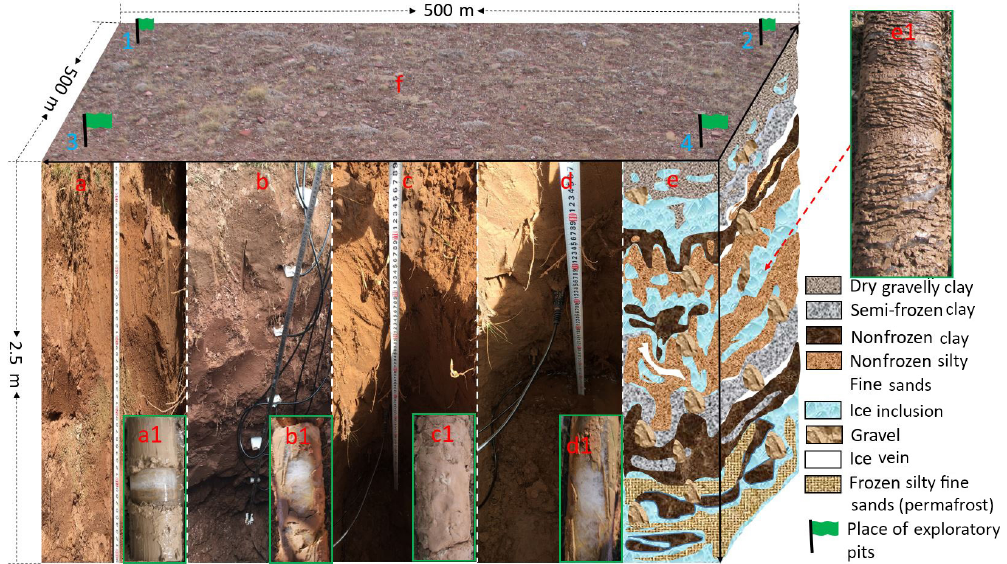
Figure 6. Location of exploratory pits and drillings in this study in autumn: (f) photo of a typical ground surface (16 October 2014). Green flags represent the location for the soil survey using test pits and drilling. (a, b, c, d) Soil profiles of 0–250cm of depth at the north (1), south (2), east (3), and west (4) corners of the eddy covariance footprint, respectively. (a1, b1, c1, d1) Drilling cores, with clear ice (white) in (a1, b1, d1) , but not in (c1) . (e) An illustration that combines results from drillings, test pits, and multichannel ground-penetrating radar (Malå Geoscience, Sweden) for active layer variations in permafrost area during the autumn season. (e1) A core sample of the same drilling (16 October